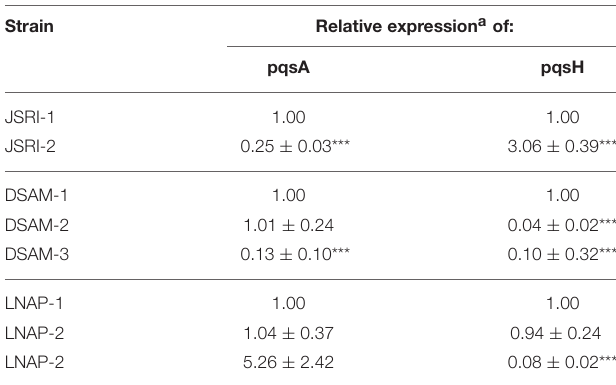
TABLE 3 | pqs gene expression by PQS-deficient CF isolates. Strain Relative expression a